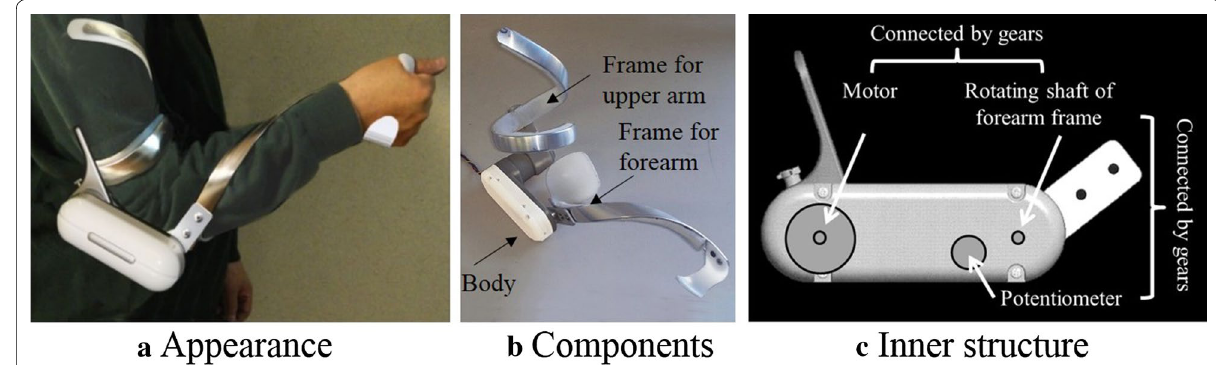
Fig. 1 Exoskeleton for essential tremor patients. In a , the appearance of the proposed exoskeleton that is worn by a user is shown, in b , compo- nents of the exoskeleton are shown, and in c , a picture of the inner structure of the body of the exoskeleton is shown